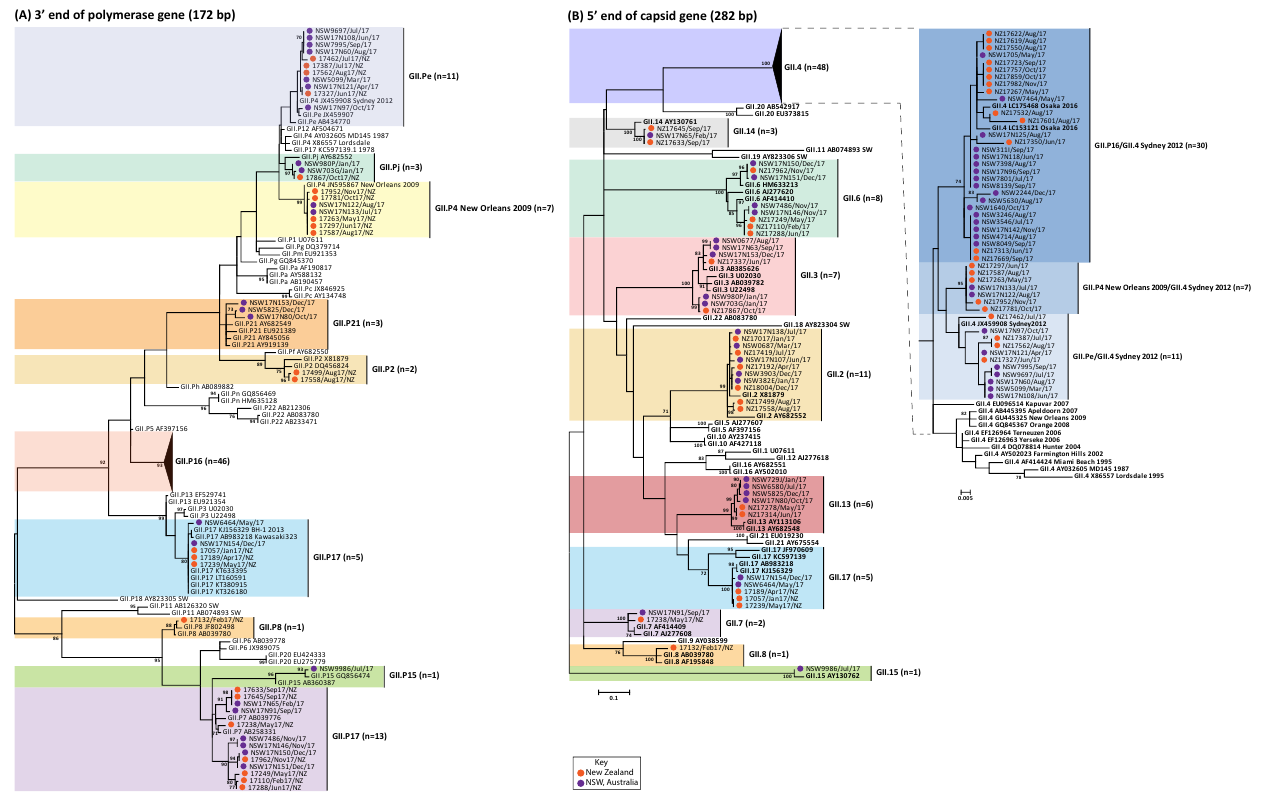
Figure 4. Phylogenetic analysis of polymerase (RdRp) and capsid (VP1) regions of GII norovirus. Representative norovirus GII strains isolated in this study ( n = 92) from both NSW, Australia and New Zealand, are shown in this phylogenetic analysis. They are denoted with a colored bullet ( • ), where Australian samples are represented in purple and New Zealand samples in orange. All samples are labelled with their geographical location and time of strain isolation. Due to the number of sequences grouped within GII.P16 and GII.4, the sequences within those clusters were compressed and represented by the black triangles. Reference strains were obtained from the GenBank database, labelled with their genotype and accession number. ( A ) Maximum likelihood phylogeny derived from partial 3 (cid:48) end of polymerase gene (172 bp) of GII noroviruses. ( B ). Maximum phylogeny derived from partial 5 (cid:48) end of capsid gene (282 bp) of GII noroviruses. Sequence alignments were performed with MUSCLE algorithm. Maximum likelihood phylogenetic trees were produced using MEGA 5 software with bootstrapping test of 1000 replicates, based on the Kimura 2-parameter model. The bootstrap percentage values are shown at each branch point for values ≥ 70%. The number of substitutions per site is indicated by the scale